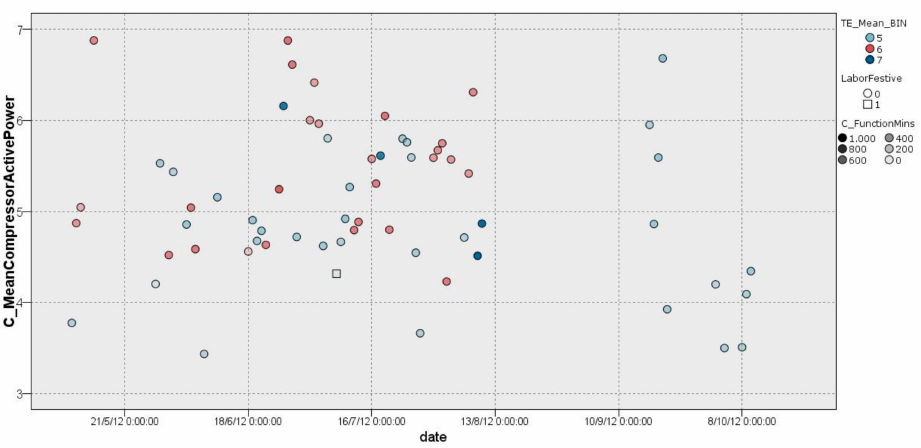
Figure 10. Graphical representation of distribution of cluster